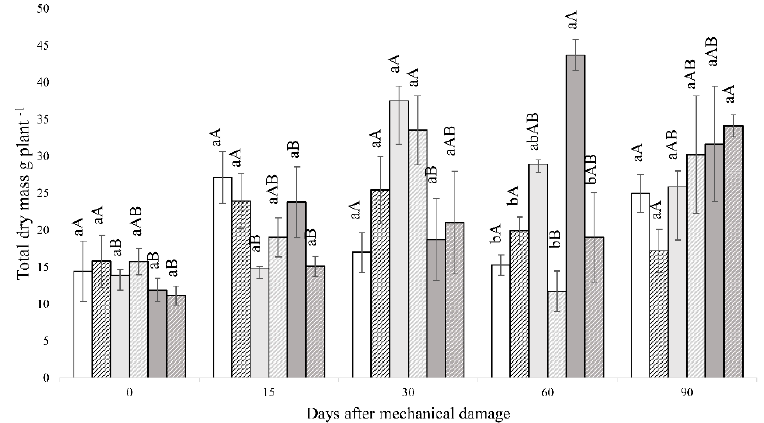
Figure 5. Total dry mass (g) p < 0.001 in Annona emarginata plants submitted to the treatments: 0 mM Ca 2+ without mechanical damage (intact), 0 mM Ca 2+ with mechanical damage (w/MD), 2 mM Ca 2+ intact, 2 mM Ca 2+ w/MD, 4 mM Ca 2+ intact, and 4 mM Ca 2+ w/MD, at evaluation times: 0 (30 min) 15, 30, 60, and 90 days. Values correspond to means ± SE ( n = 4). Lowercase letters indicate differences between treatments within each evaluation time and uppercase indicate differences between each treatment over evaluation time.